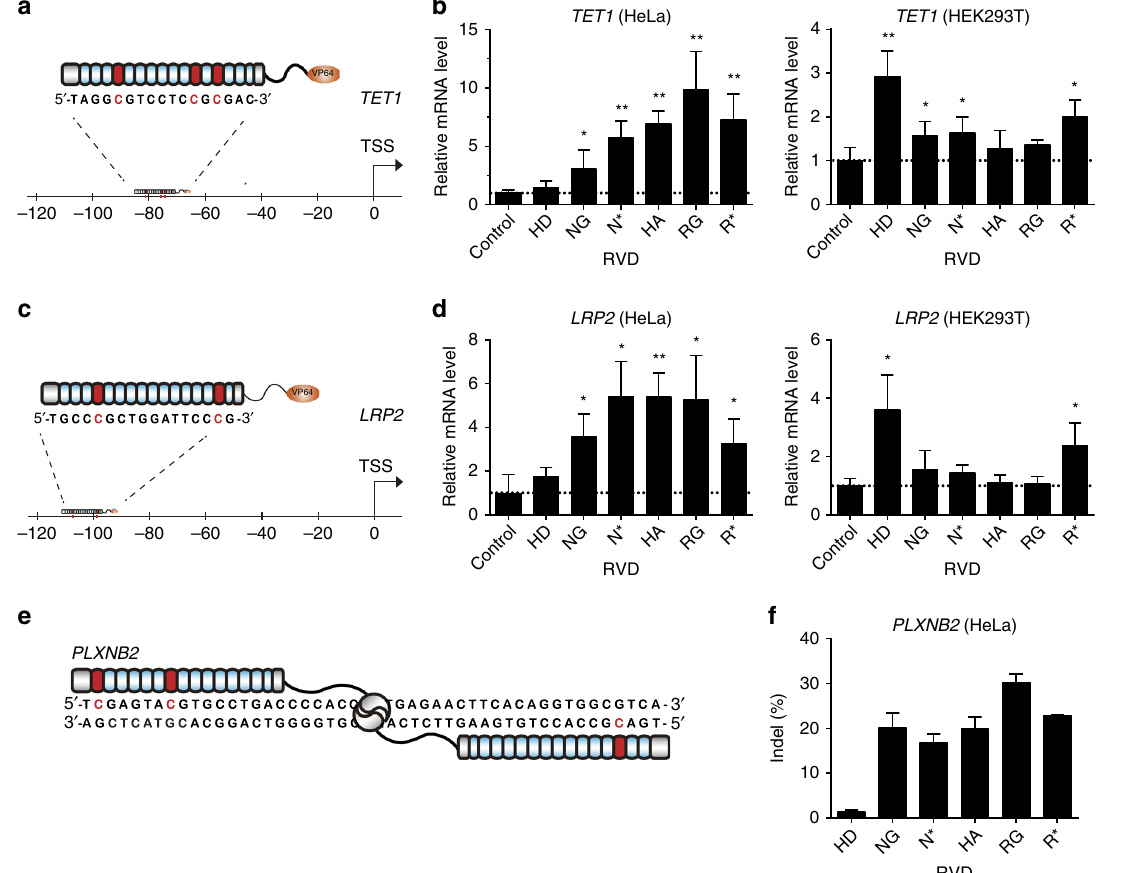
Fig. 4 Methylation-dependent gene expression activation and genome editing. a TALE TET1 targets a 16 bp DNA sequence ~80 bp upstream of the transcription start site ( TSS ) of the TET1 gene. All three CpGs (whose Cs are indicated in red ) in the region are highly methylated in HeLa cells but unmethylated in HEK293T cells. b The relative mRNA level of TET1 in HeLa and HEK293T cells transfected with TALE TET1 containing different RVDs. c TALE LRP2 targets a 16 bp sequence ~ 100 bp upstream the TSS of the LRP2 gene. Both the two CpGs in this region contain medium-level methylation in HeLa cells while are unmethylated in HEK293T cells. d The relative mRNA level of LRP2 in HeLa and HEK293T cells transfected with TALE LRP2 containing different RVDs. e The position of TALEN targeted sequence. The methylated CpGs are indicated in red . f The genome editing ef fi ciency of TALEN using different RVDs. The data are means + s.d., n = 3; * P < 0.05, and ** P < 0.005 two-tailed unpaired Student ’ s t